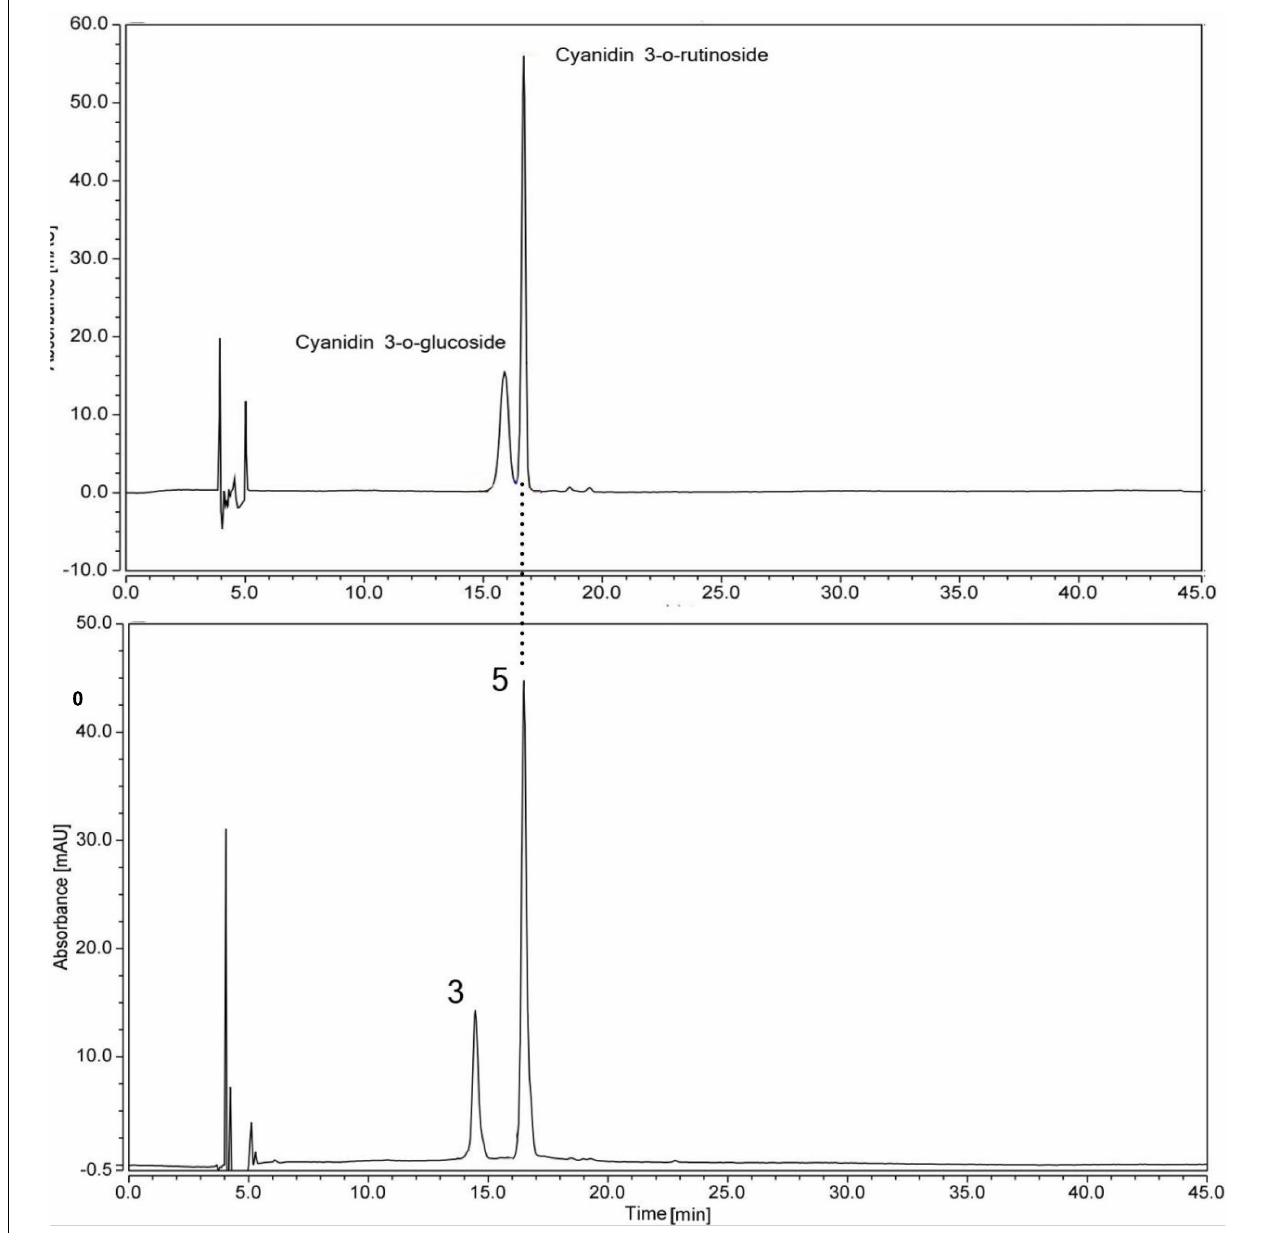
FIGURE 3 | HPLC chromatogram of a mix of standard anthocyanins and flavonoids extracted from the petal eye of ‘Little Bumble Bee’ (detection at 520 nm). Peak numbers were the same as shown in Table 2